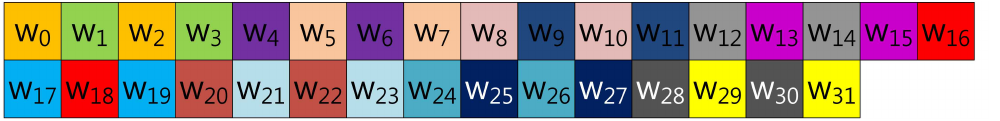
Figure 19. Look-up table structure of the proposed 2NAF method in block